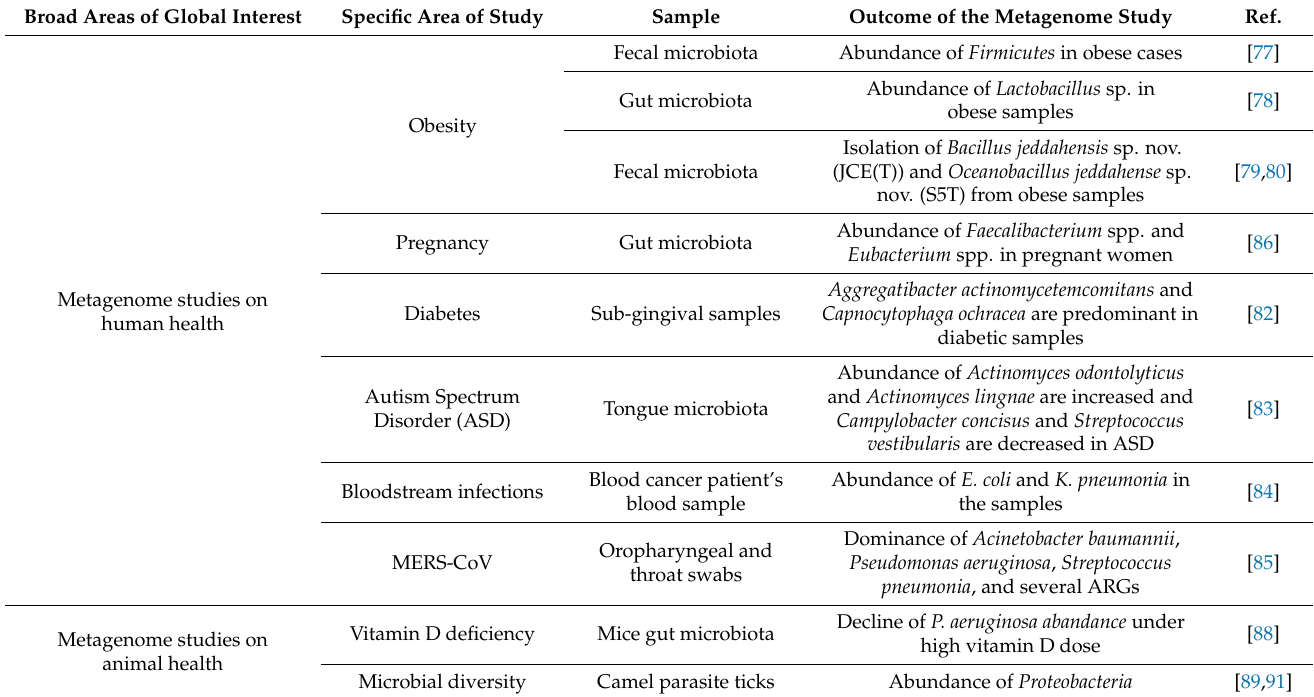
Table 2. Metagenome-based microbiome studies from Saudi Arabia in the last 10